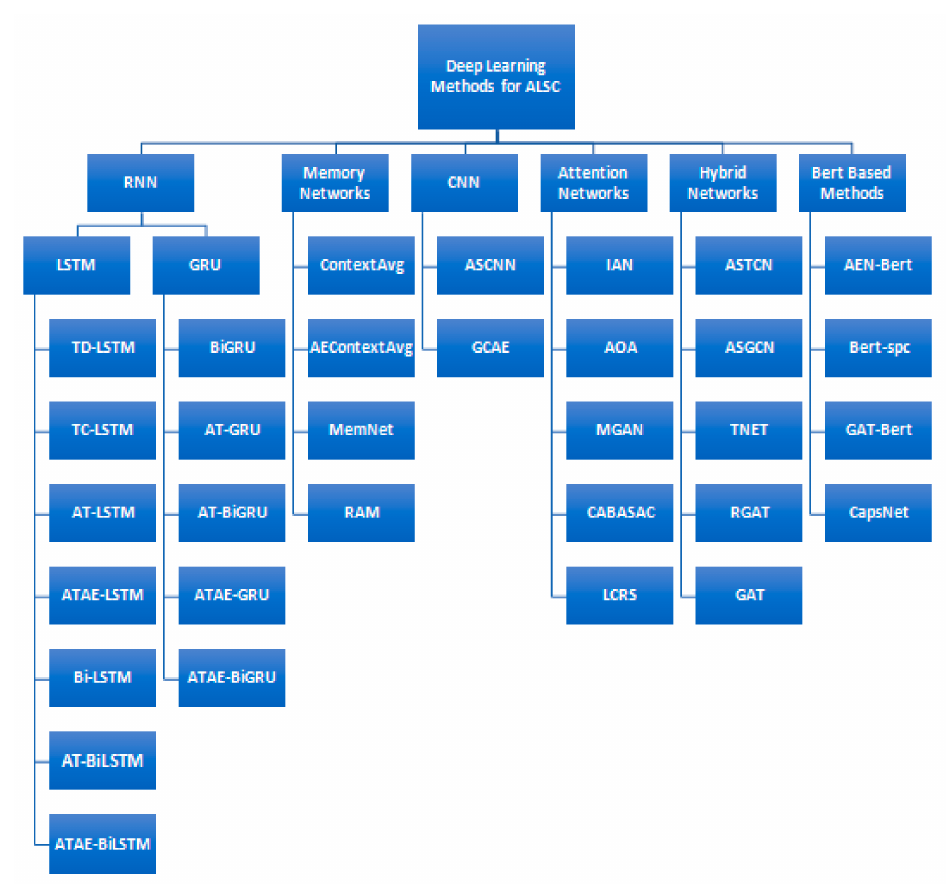
Figure 4. Deep Learning Methods for